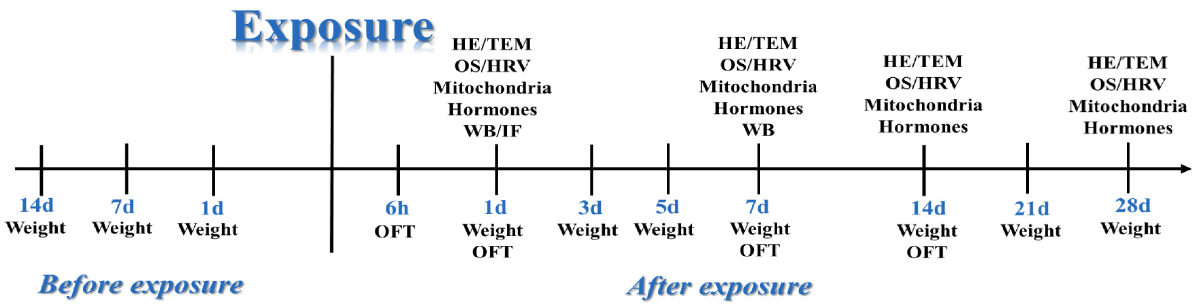
Figure 21. Experimental schedule.